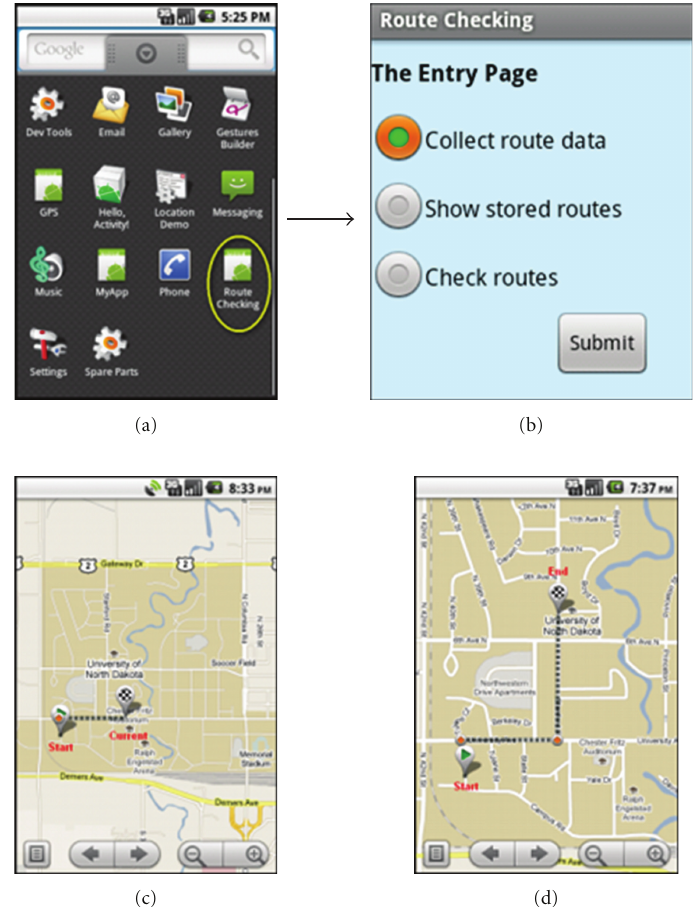
Figure 3: (a) The application icon “Route Checking” on a device, (b) the entry page of the application, (c) the current route map, and (d) an example of a stored